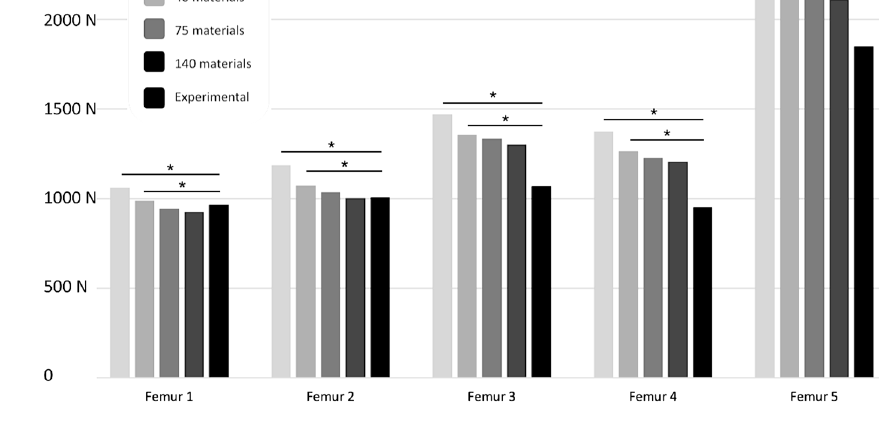
Fig. 9 Quantity of materials used and respective effects on reaction force simulation results